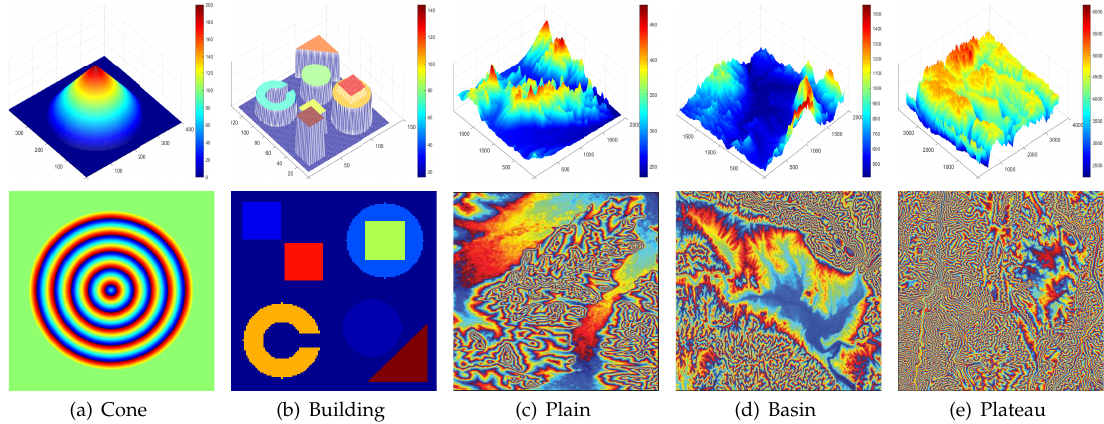
Figure 4. Five different topography (top) and their typical interferogram (bottom): ( a )–( e ) represent cone, building, plain, basin and plateau respectively.